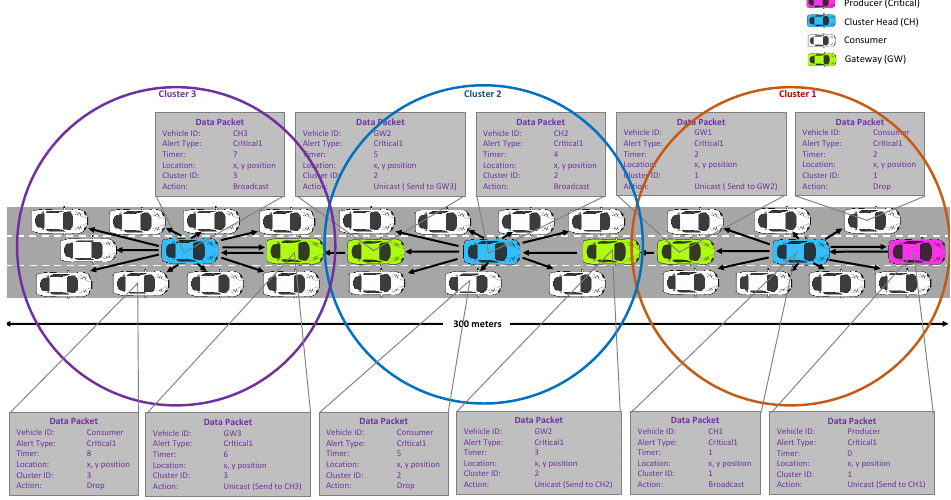
Figure 5. Example of a critical data forwarding scenario in the proposed push-based forwarding scheme using fuzzy logic